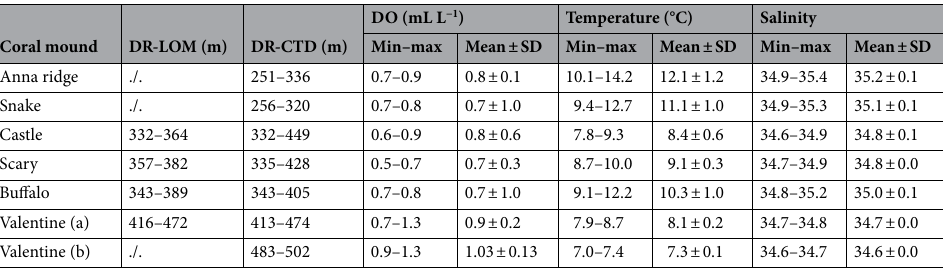
Table 3. Depth range of living occurrence of Madrepora oculata (DR-LOM) recorded for each cold-water coral mound. Additionally, the range and mean values of environmental parameters (DO: dissolved oxygen concentrations) recorded by a CTD installed on the ROV during video observations are provided (DR-CTD: depth range of CTD measurements) .